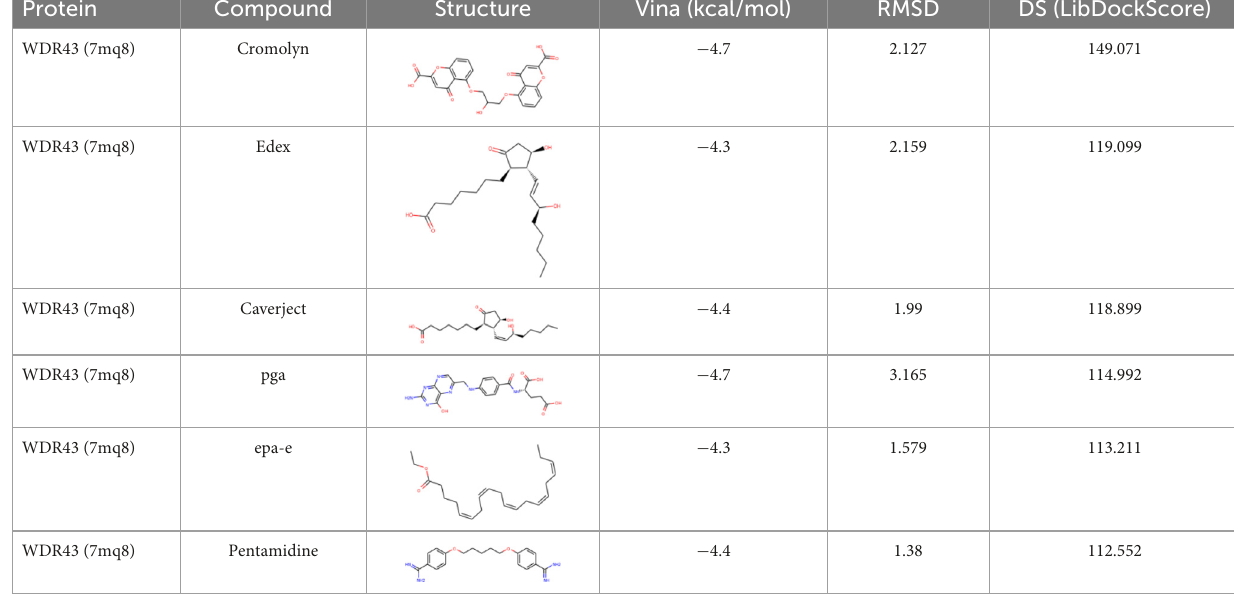
TABLE 1 Docking of WDR43 with the first six compounds. Protein